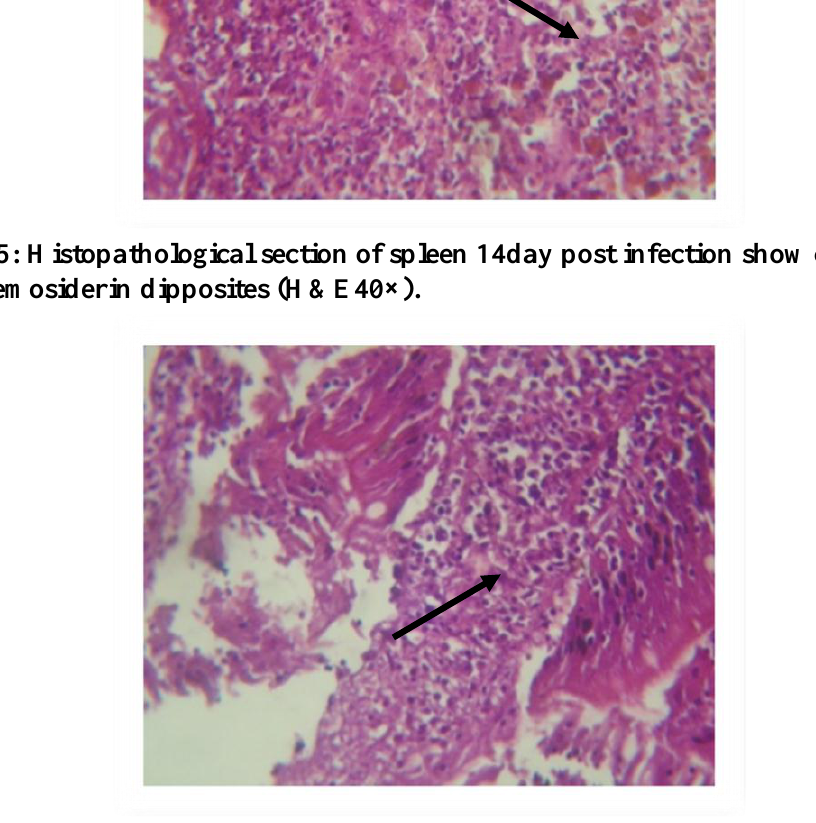
Figure6: Histopathological section of intestine 14-day post infection show present of cellular detritous in the lumen with sloughing of enterocyte (H&E40×). The presence of Aeromonads particularly A.hydrophila in healthy and diseased fish of the Cyprinus carpio obtained from different localities suggests an epizootic. (17) were able to isolate Aeromona spp . from healthy tilapia tissues such as kidney, spleen and liver. LD of A.hydrophila was 2.94 ×10 7 cfu/ml in common carp ( Cyprinus 50 carpio )(18) (19) used 1.5-0.3 × 10 6 cfu/ml intraperitonealy for all fingerlings groups while (20), found the LD of A.hydrophila was 6×10 7 cfu /ml when injected Cyprinid 50 loaches